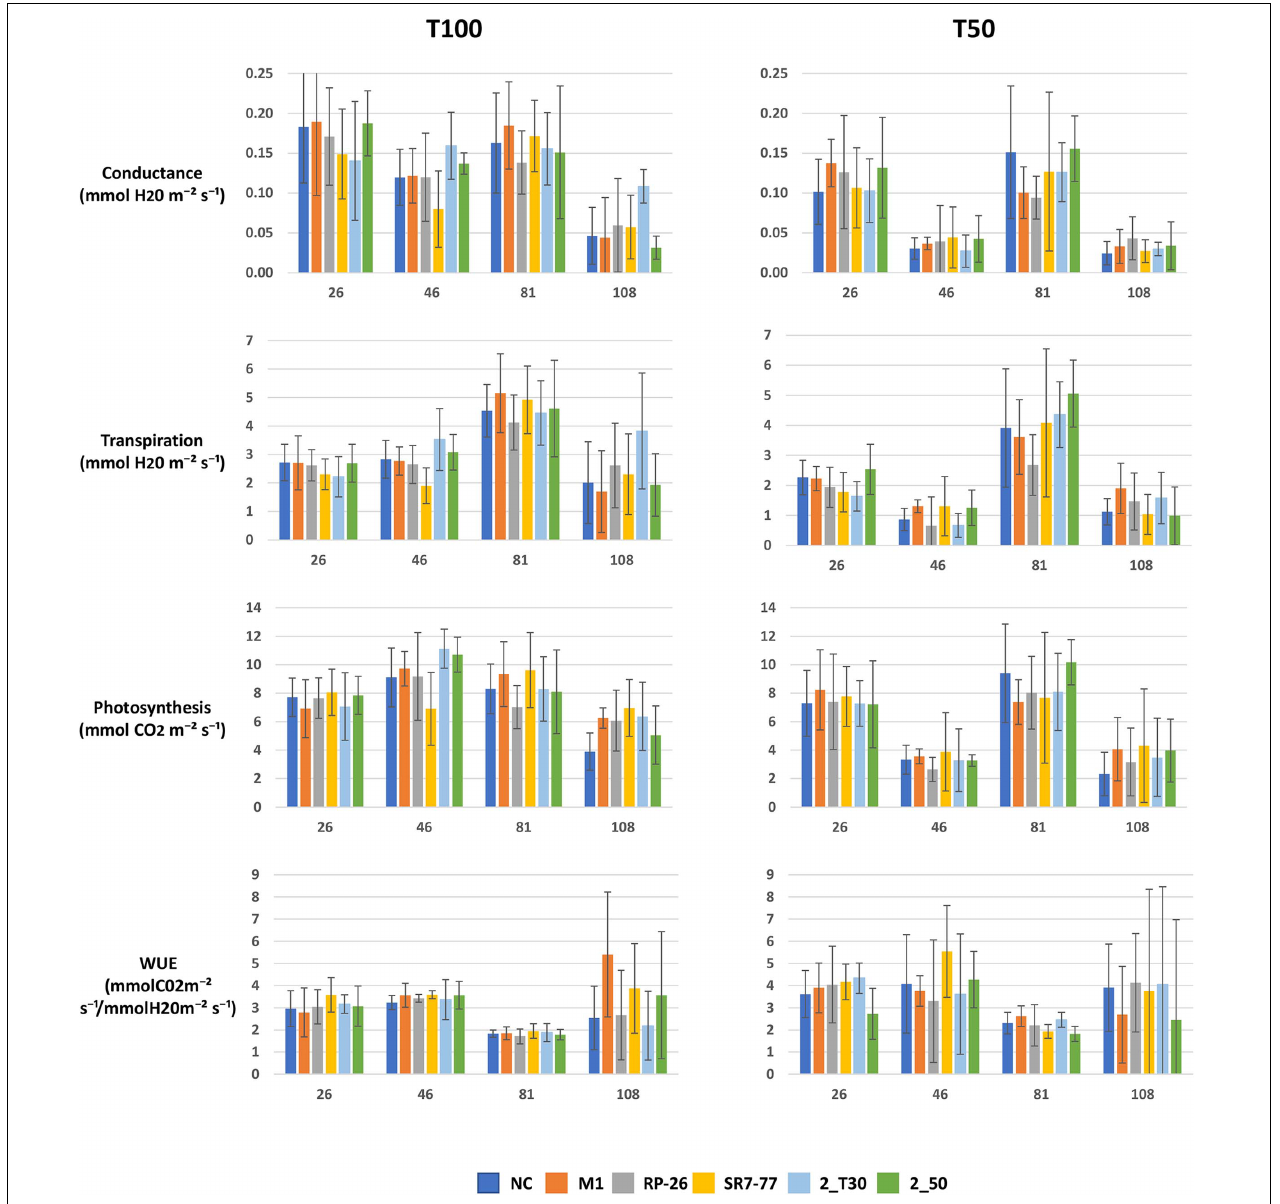
FIGURE 1 | Effect of PGP bacteria inoculation on tomato plant physiological parameters (i.e., stomatal conductance, transpiration rate, photosynthesis, and leaf WUE) of plants grown under full irrigation condition (T100) and water stress (T50) during different plant growth stages: 26 = 26 dat, vegetative stage; 46 = 46 dat, flowering stage; 81 = 81 dat, fruit setting stage; 108 = 108 dat, mature fruiting stage. Data are represented as average value ( n = 5) with bars referred to standard deviation. NC, non-bacterized control plants; PGP bacteria strains: Micrococcus yunnanensis M1, Bacillus simplex RP-26, Pseudomonas stutzeri SR7-77, Paenarthrobacter aurescens 2_T30 and Paenarthrobacter nitroguajacolicus